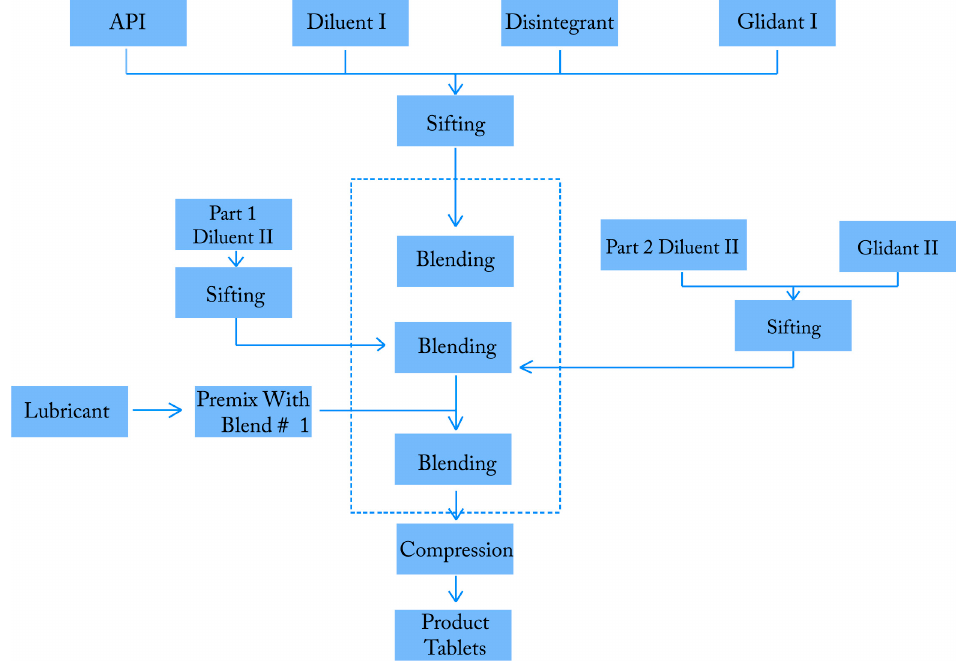
Figure 2. Manufacturing process flow chart after improvement.